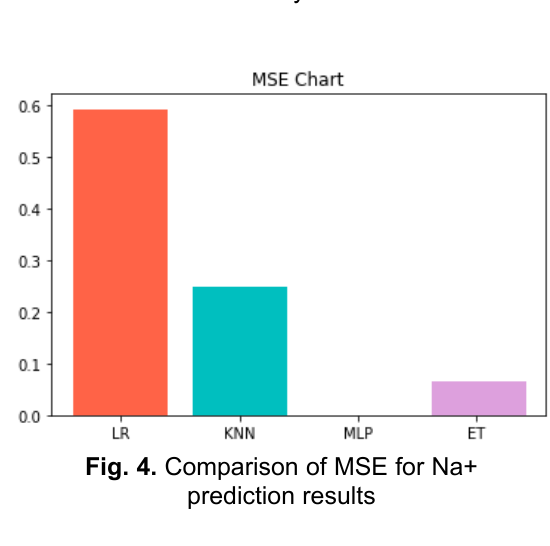
Fig. 4. Comparison of MSE for Na+ prediction